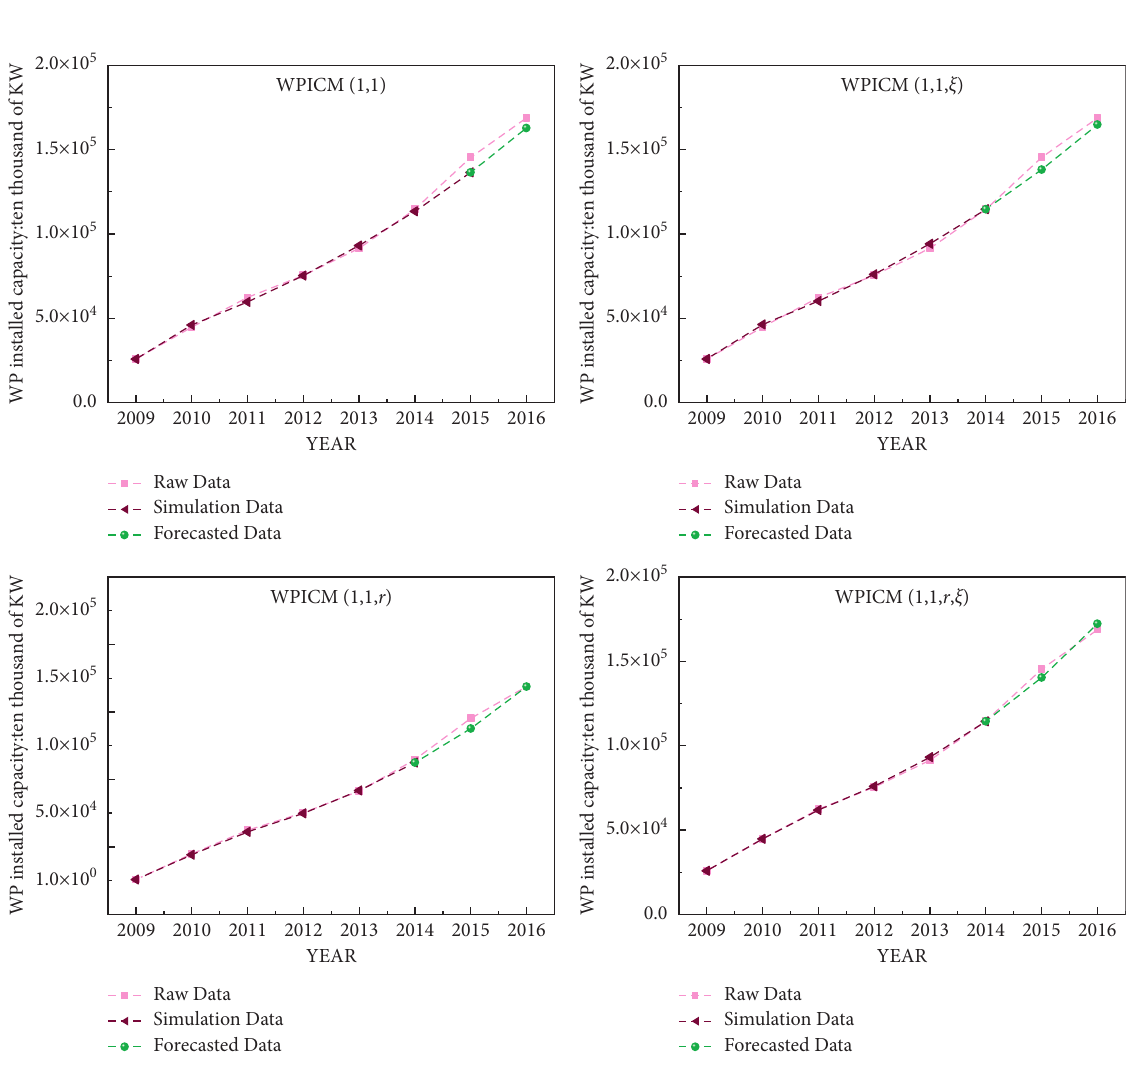
Figure 5: Performance